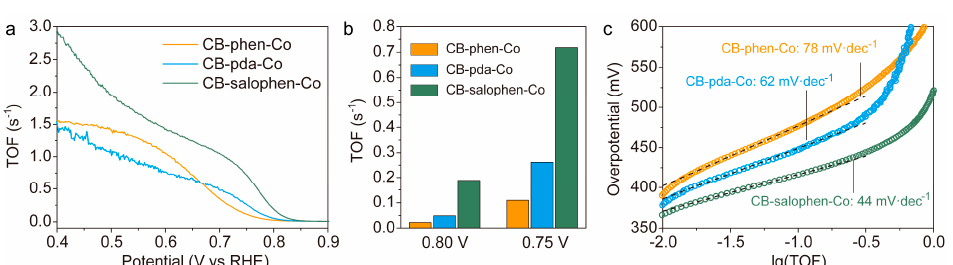
Figure 7. Comparison of ORR activity of CB-conjugated complexes. ( a ) Curves of TOF based on the potential. ( b ) Comparison of TOF at 0.80 V and 0.75 V vs. RHE. ( c ) Tafel plots. The Tafel slope of each catalyst is indicated.